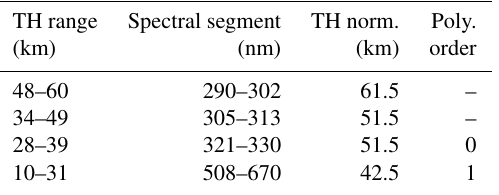
Table 1. List of the spectral segments considered in the ozone re- trieval, with corresponding TH range, altitude used for the normal- ization, and order of the subtracted polynomial ( “–” means that no polynomial is